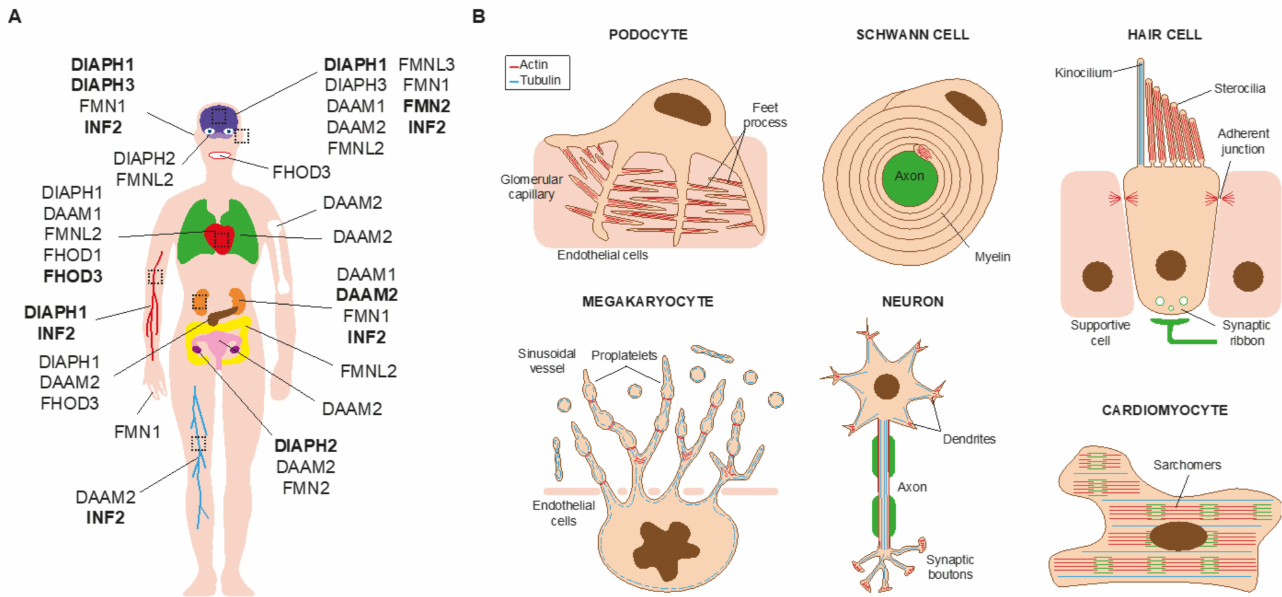
Figure 3. Some of the organs and cell types affected by formin alterations. ( A ) The formins involved in human disorders and the affected organs and systems are indicated in the schematic of the human body. Those causing monogenic disorders are highlighted in bold. ( B ) Some of the affected cell types. Their most characteristic structures are